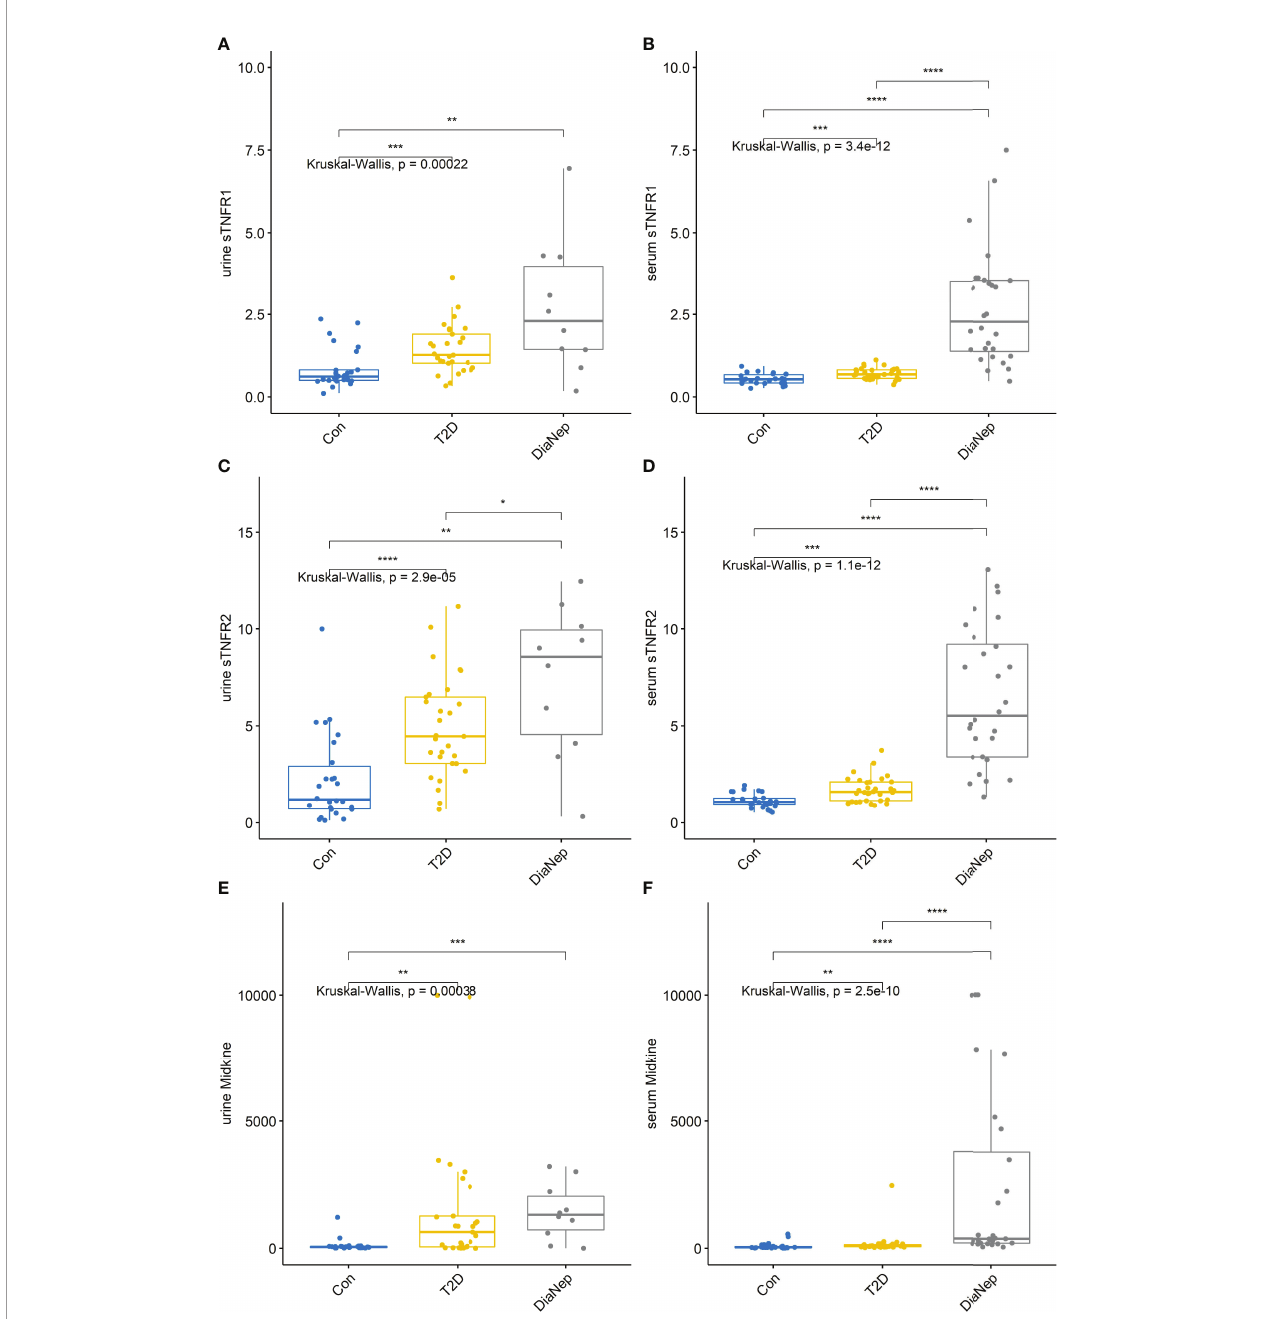
FIGURE 2 | Urine and serum levels for sTNFR1 and 2 and midkine increased across all groups (A) urine sTNFR1, (B) serum sTNFR1, (C) urine sTNFR2, (D) serum sTNFR2, (E) urine midkine, (F) serum midkine. Stars of signi fi cance *p<0.05, **p<0.01, ***p<0.001, and